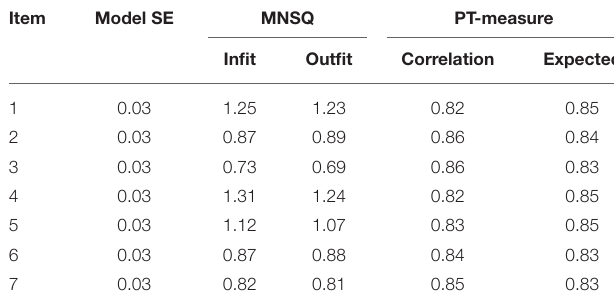
TABLE 3 | Model fit for each